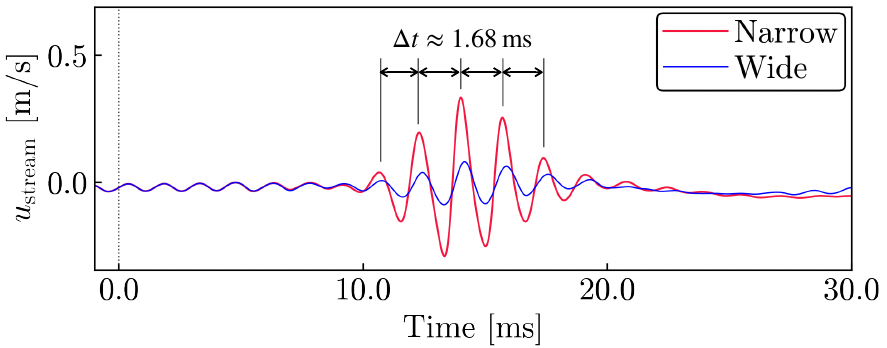
Figure 17. The figures show stream-wise velocity measured at x = 225 mm (corresponding to 90% chord position) on the lower side surface.